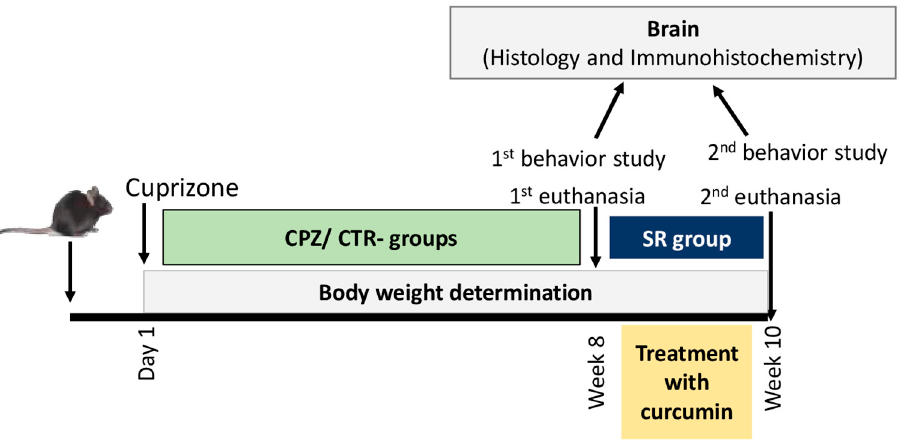
Figure 10. Schematic description of encephalomyelitis auto-immune experimental (EAE) design. Negative group (CTR-), EAE-mice (EAE) group, post-treated with curcumin (CUR) group and spontaneous recovery mice (Srec) group.